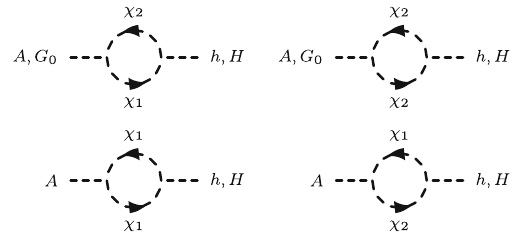
Fig. 2 Feynman diagrams contributing to the one-loop CP violating 2-point